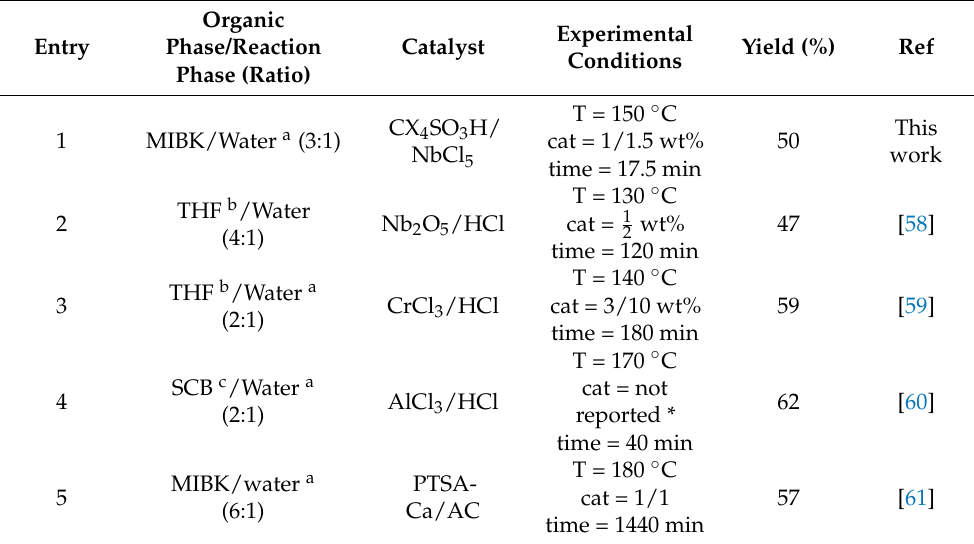
Table 4. Comparison of methodology developed for the conversion of glucose to HMF with data from the